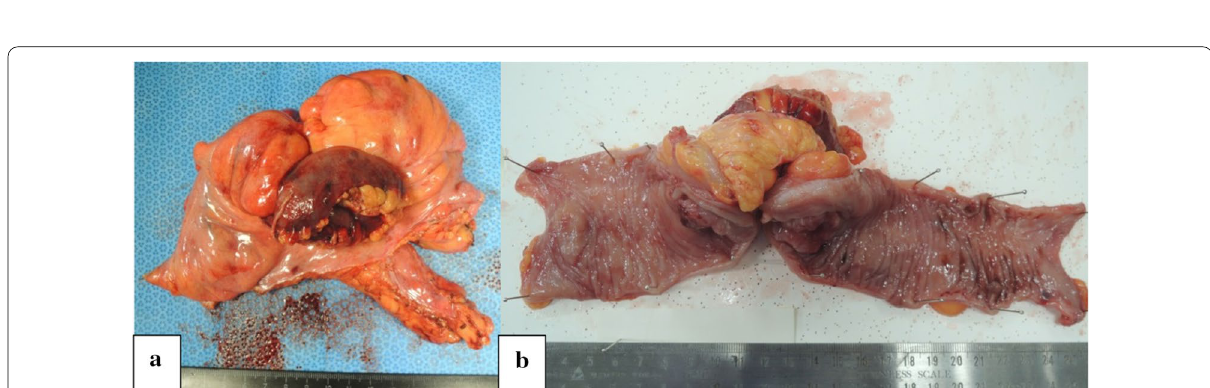
Fig. 4 a, b Sigmoid colon cancer with invaded ileum was resected en bloc. Ileal mesentery resection was performed to a minimum